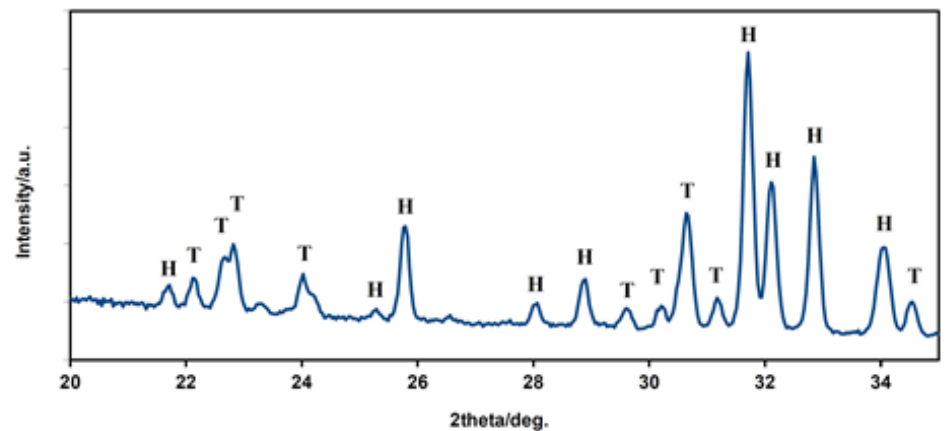
Figure 3. XRD patterns of HAP biphasic ceramics. The XRD phase analysis identified biphasic CaP ceramics with HA (H) as the main phase and α -TCP (T) as the secondary phase. The composition corresponds to a small chemical nonstoichiometry of HAP powder during synthesis. H—hydroxyapatite, T— α tricalcium phosphate.